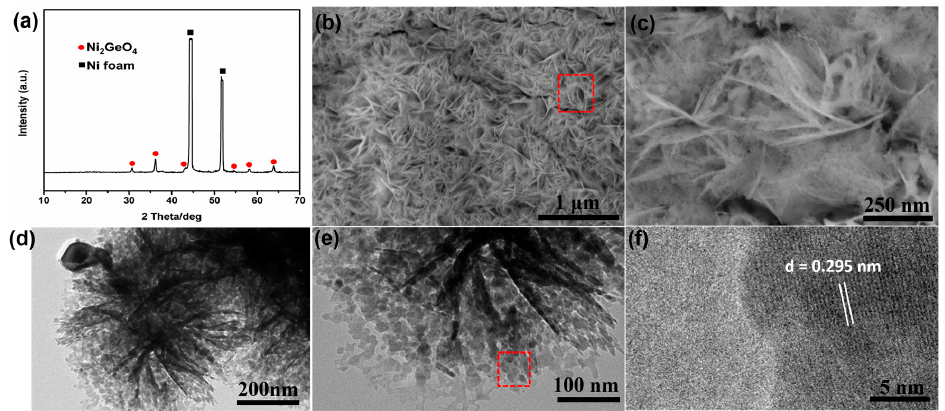
Figure 2. ( a ) XRD patterns, ( b , c ) SEM, ( d , e ) TEM, and ( f ) high-resolution TEM (HRTEM) images of